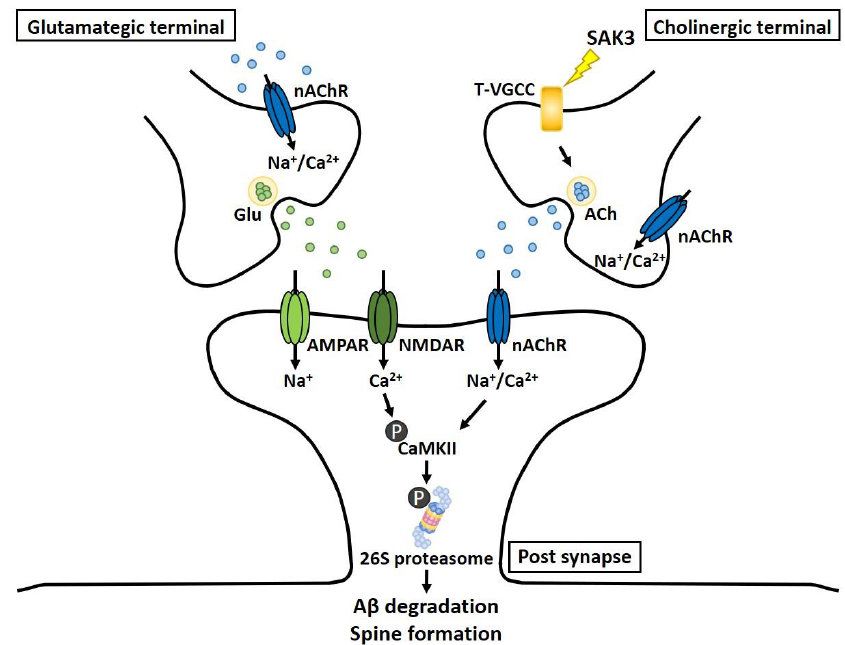
Figure 8. Schematic depicting the mechanism underlying the therapeutic effects of SAK3 administration for AD pathology. SAK3 stimulates T-type calcium channels at cholinergic terminals, triggering intracellular calcium influx, followed by ACh release. Released ACh stimulates nAChRs at glutamatergic terminals, facilitating Glu release. Potentiation of CaMKII/Rpt6 signaling via nAChR and NMDAR activation contributes to an increase in proteasomal activity. Elevated proteasomal activity may account for Aβ degradation an d synaptic plasticity.